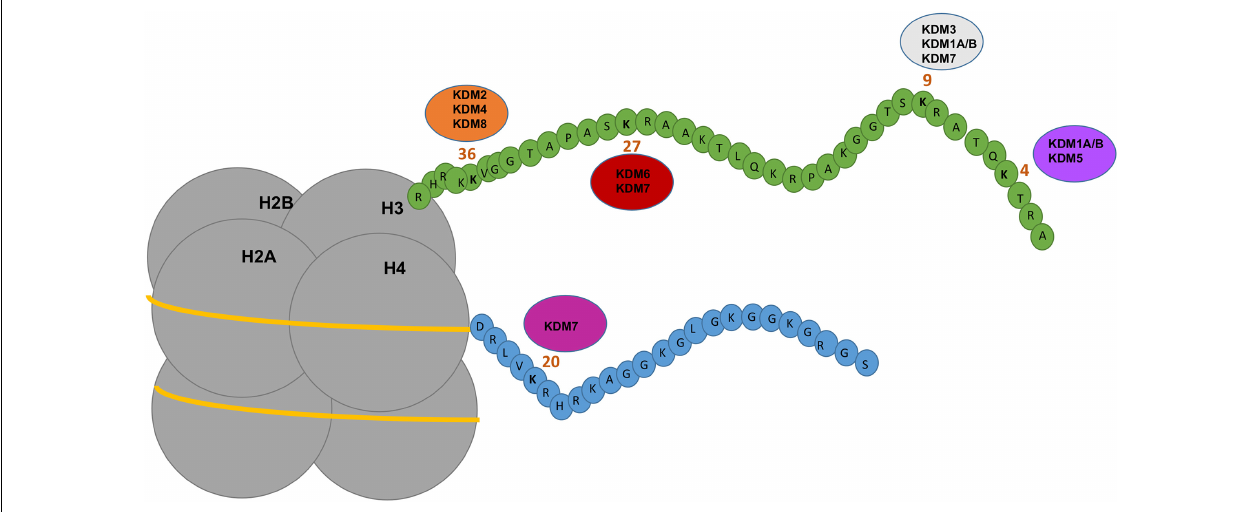
FIGURE 1 | Depicting the mechanism of action of KDMs on histones. Nucleosomes consist of four subunits of histones which contain amino acid tails that are modified by epigenetic regulators including KDMs. KDM1A/B demethylates H3K9me1/H3K9me2 and H3K4me1/me2 inducing gene repression or activation. KDM2 and KDM4 demethylases target H3K36me1/me2/me3 inducing gene activation. KDM3 demethylases target H3K9me1/me2 inducing gene activation. KDM5 demethylases targets H3K4me2/me3 inducing gene repression. KDM6 and KDM7 demethylases target H3K27me2/me3 inducing gene activation. KDM7 demethylases target H4K20me1 and H3K9me2/me3. KDM8 demethylase target H3K36me3 inducing gene activation. Figure is adapted from Verde et al.